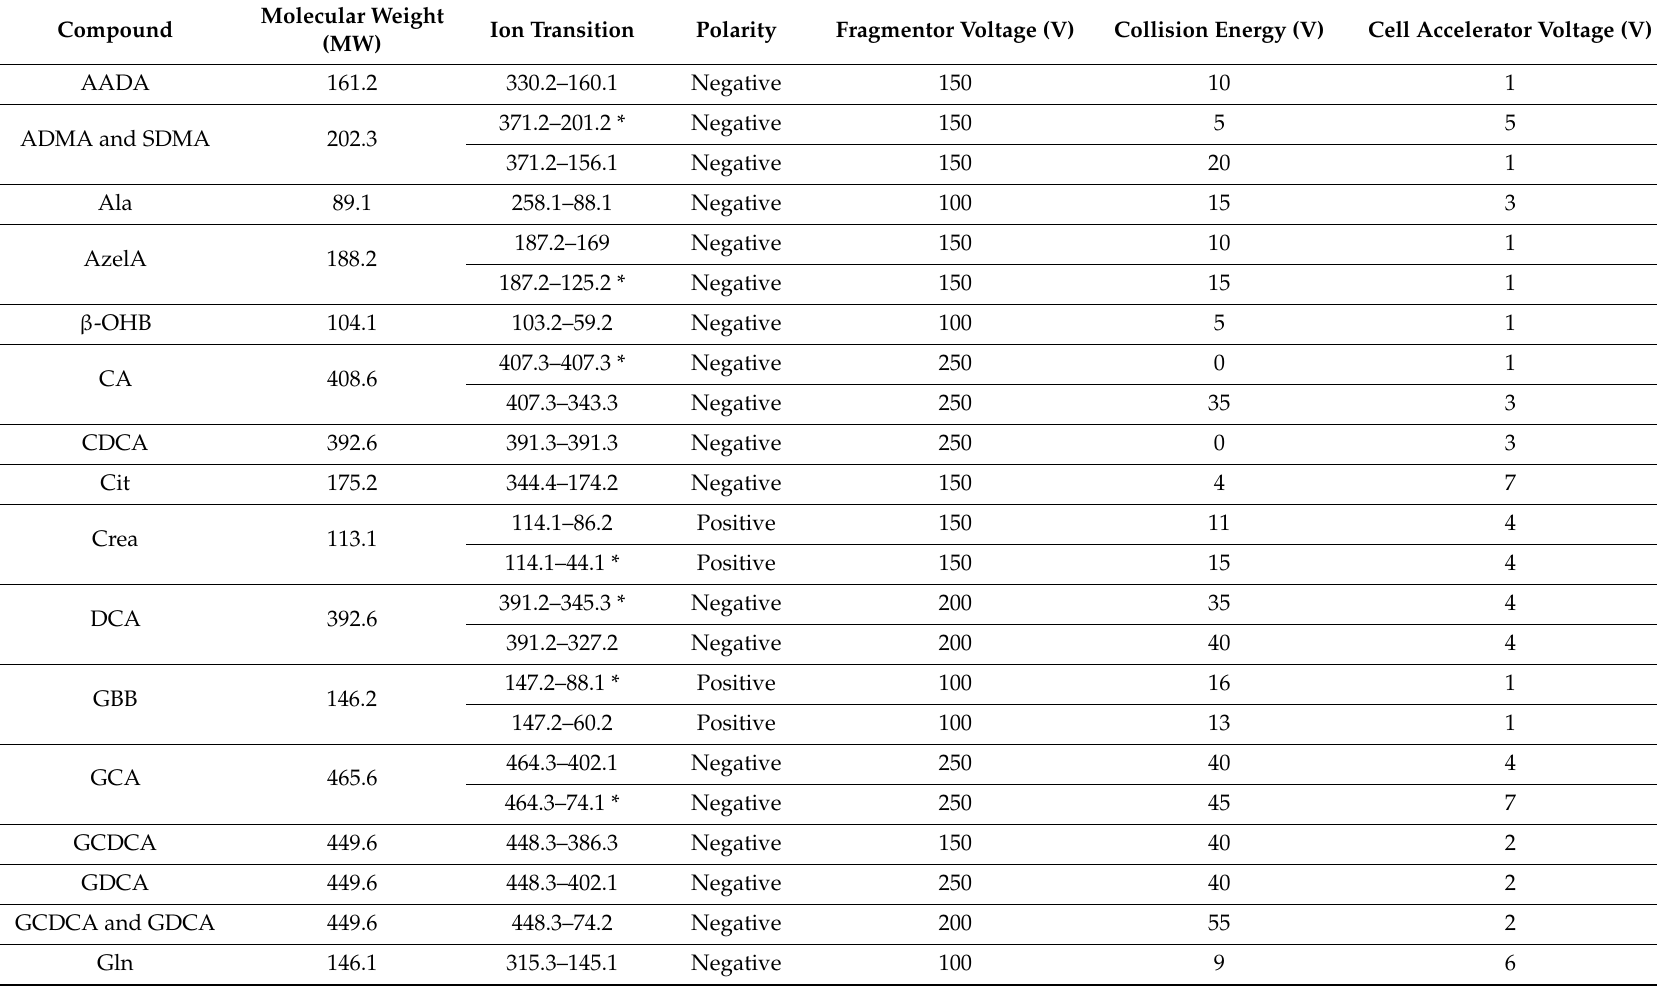
Table 2. Optimized fragmentor voltages, collision energies (CE), and cell accelerator voltages for each ion transition of the analytes and internal standards. The ion transition used for quantification is marked with an